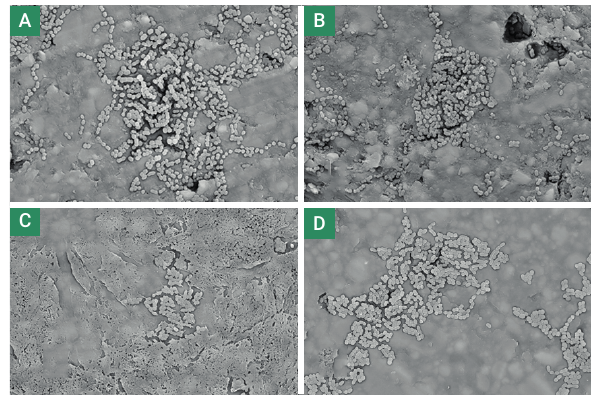
Figure 2. Photomicrographs of surfaces of nano ceramic resin (LV) after different finishes and bacterial adhesion. Control (A), diamond bur (B), Vita polishing system (C), and Dedeco polishing system (D) (5000 X).